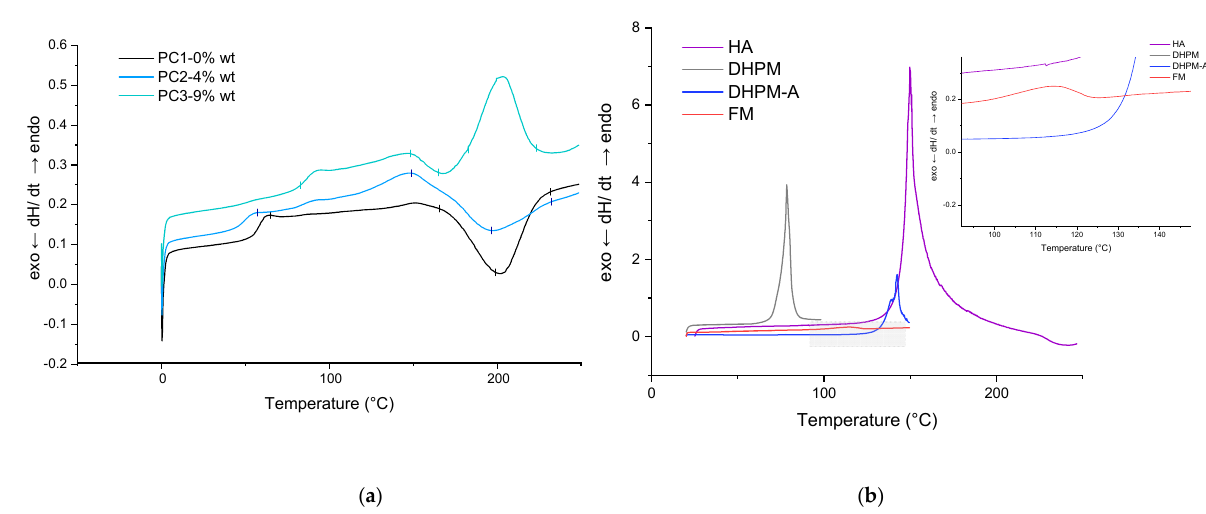
Figure 4. DSC results for first heating scan of powder material: ( a ) reference, PC2 and PC3; ( b ) HA (and each of its components). Table 2. Glass transition temperature (T g ) for each sample from DSC measurements for cycles of heating from 0 to 250 ◦